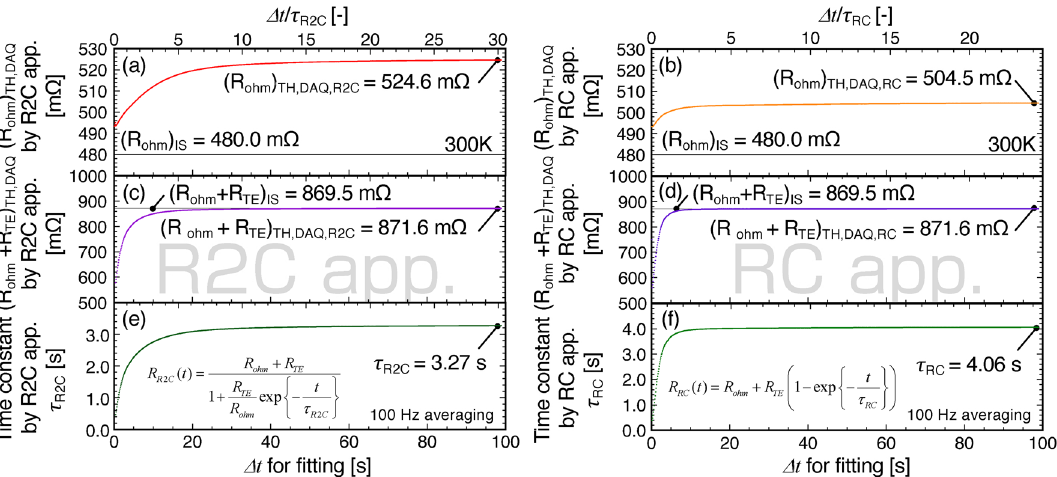
Figure 4. Estimated ( a , b ) ( R ohm ) TH,DAQ (= R mea ( t = 0)), ( c , d ) ( R ohm + R TE ) TH,DAQ (= R mea ( t → ∞)), and ( e , f ) time constant ( τ R2C and τ RC ) by R2C and RC approximation using the Eqs. (3) and (4) for the period Δt in Fig. 3c using the DAQ system (100 Hz averaging), respectively. The upper axes show the normalized time Δt / τ R2C or Δt / τ RC ,